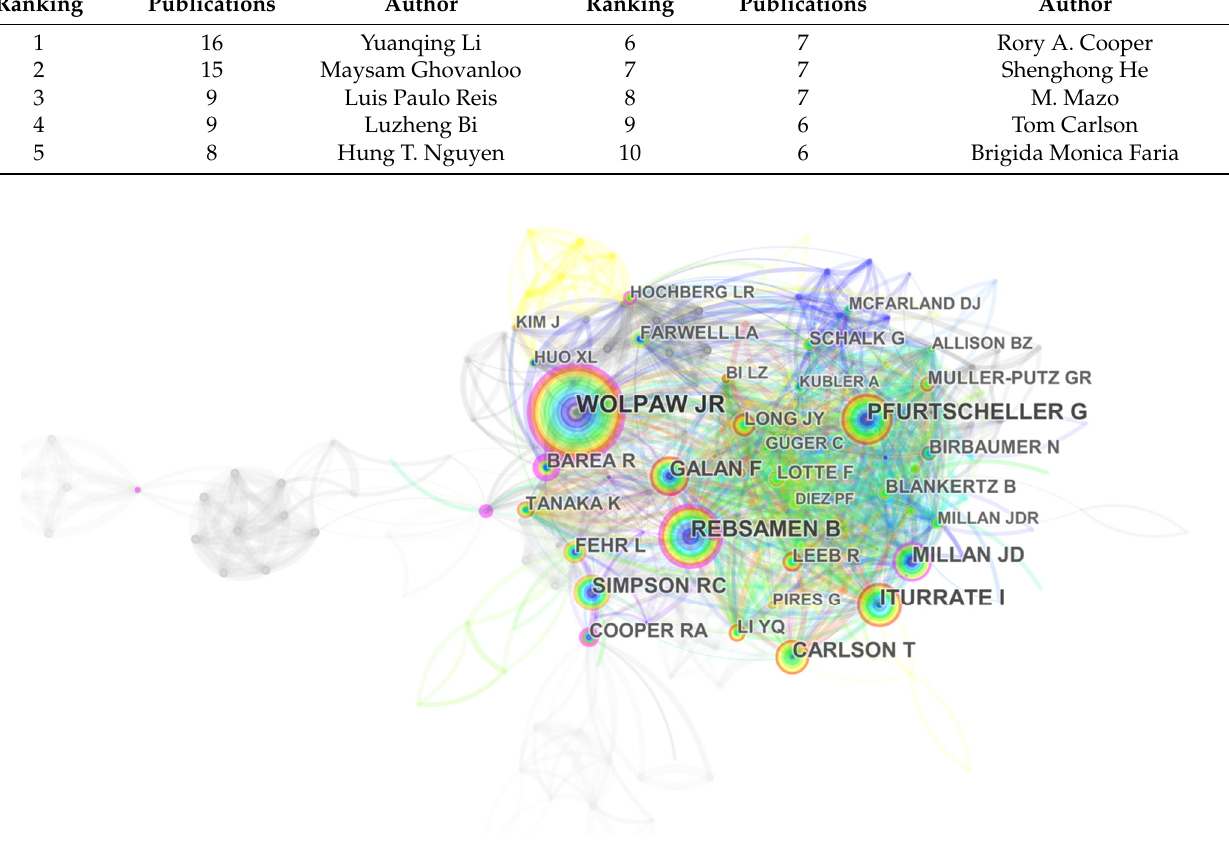
Figure 6. Author co-citation map related to EPW HMI methodology research from 1998 to 2020. Table 6. Top 5 co-cited authors involved in EPW HMI methodology research in terms of co-citation count and centrality.